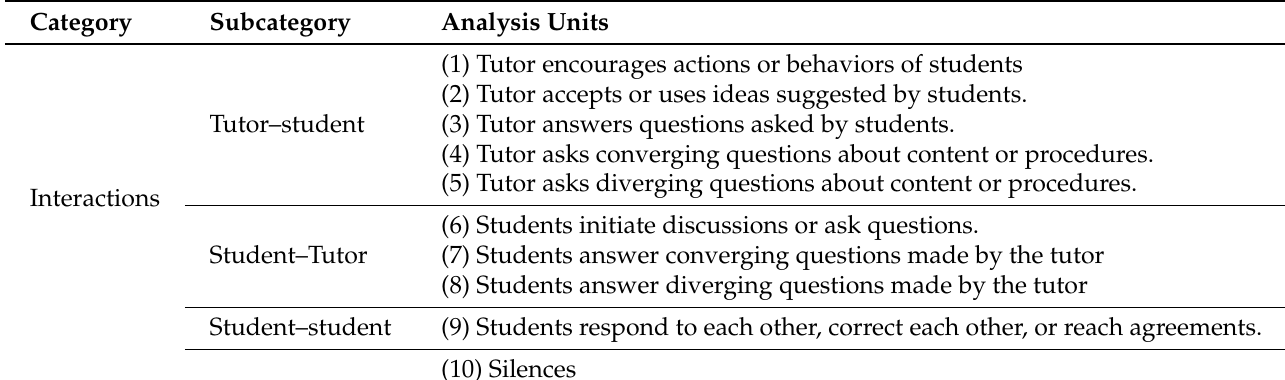
Table 1. Interaction analysis